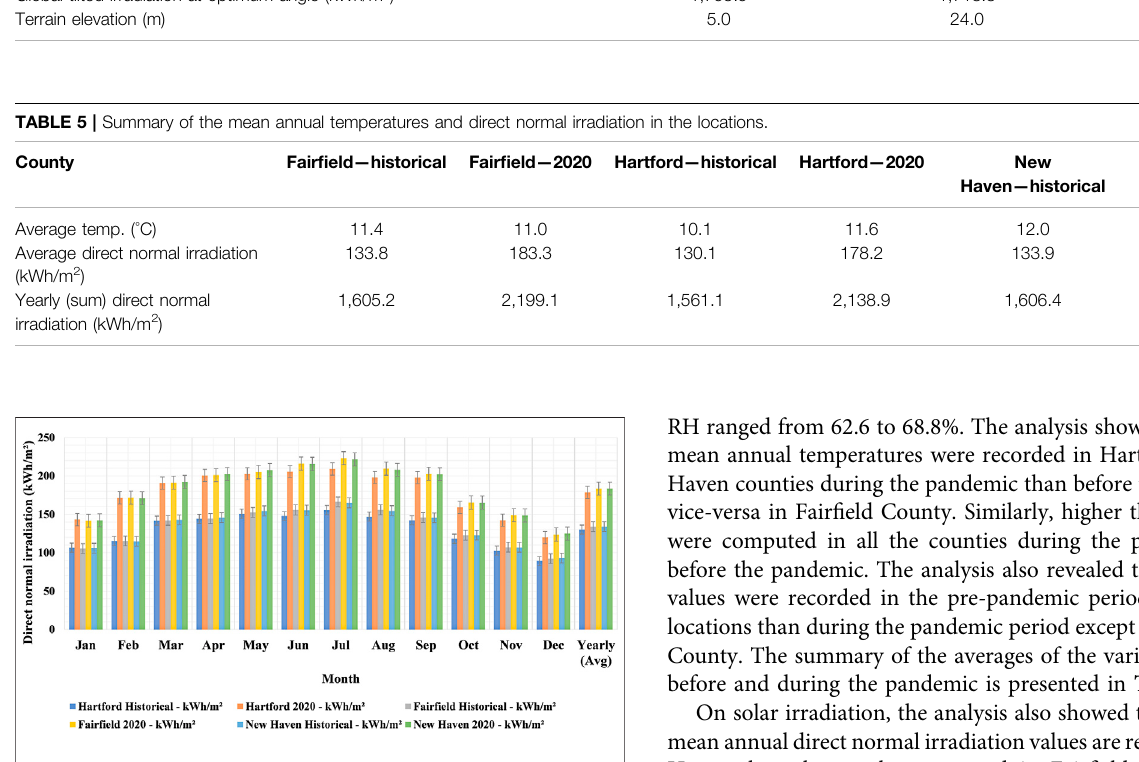
FIGURE 7 | Comparison of the mean monthly and annual direct normal irradiation values (historical and 2020) in Fair fi eld, Hartford, and New Haven.